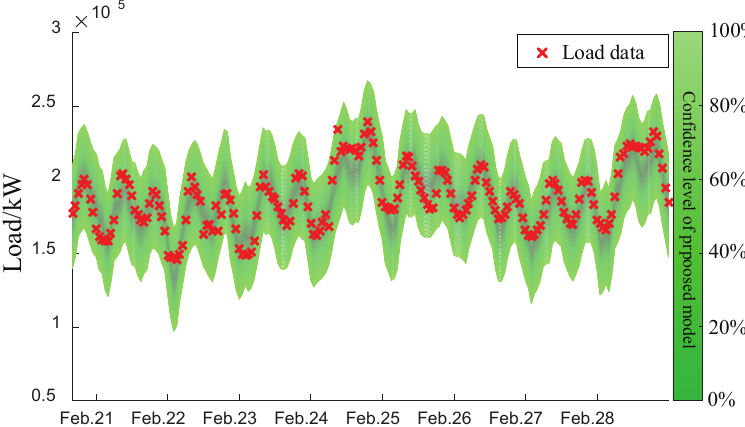
Figure 10. The latter 200 h of results predicted by the proposed